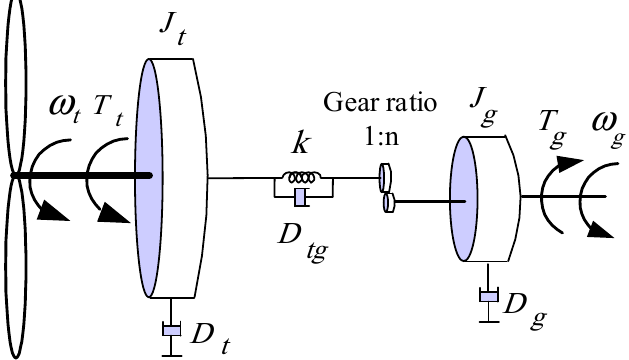
Figure 9. Dynamic model of a wind turbine.